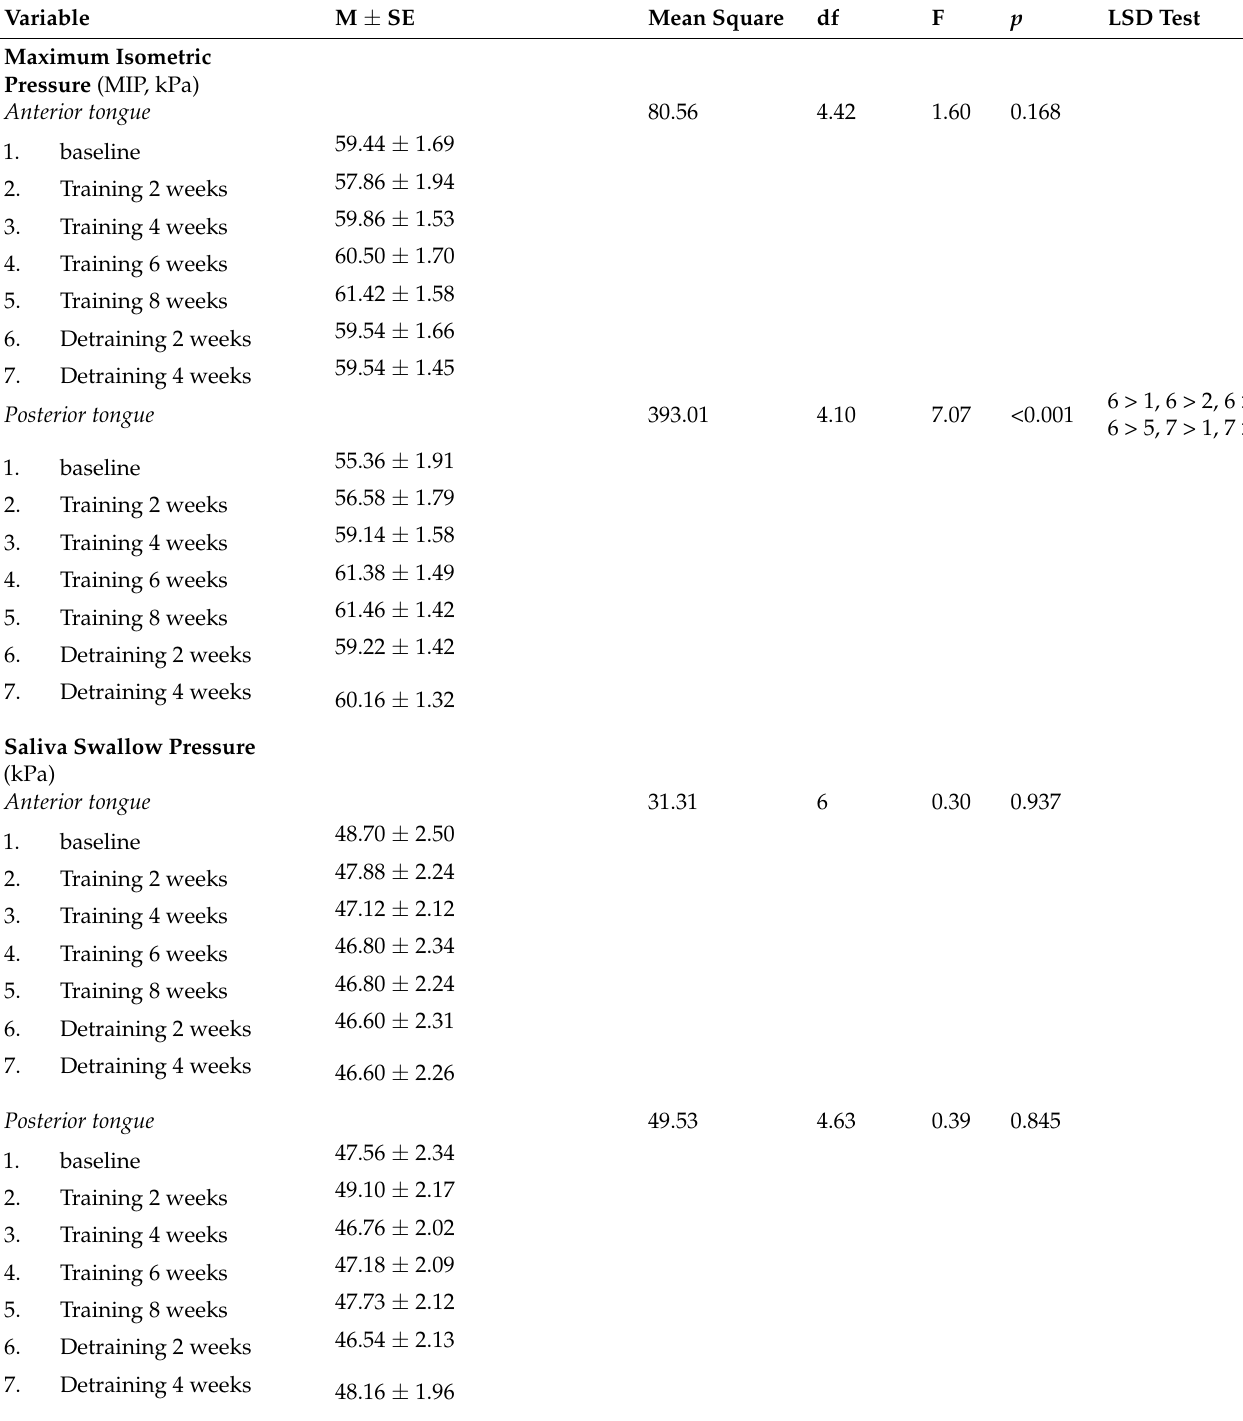
Table 4. Detraining effects of the tongue pressure ( n =